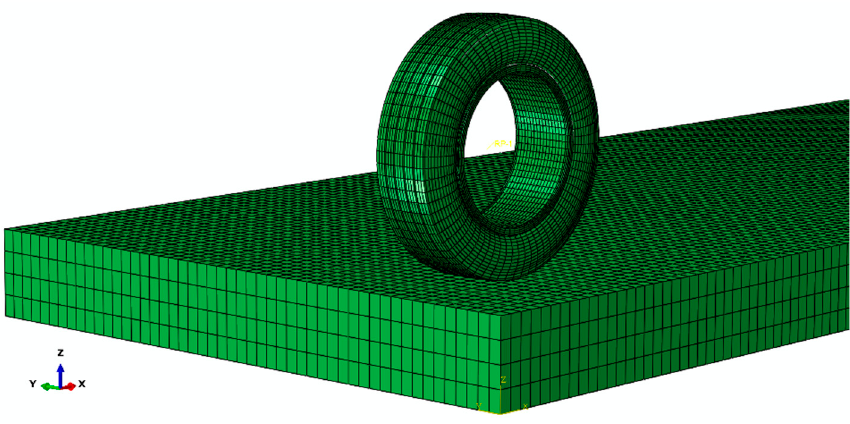
Figure 2. Finite element models of the tire and pavement.